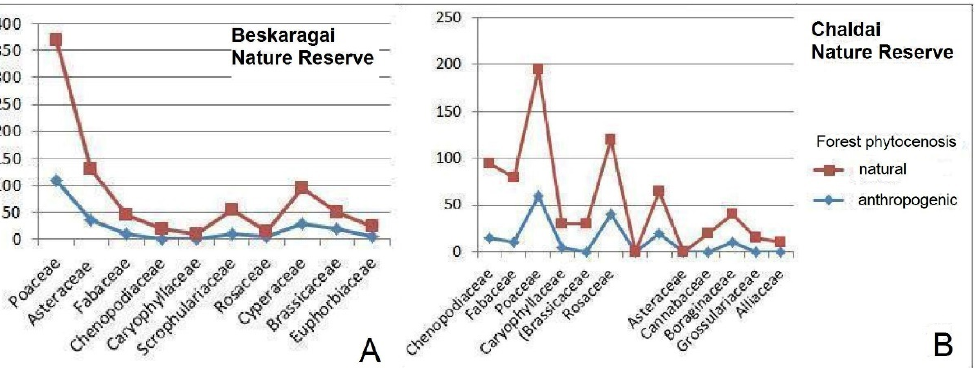
Figure 7. Pine forest undergrowth phytocenosis of the natural and invasive anthropogenic plant species in the Beskaragai ( A ) and Chaldai ( B ) nature reserves.